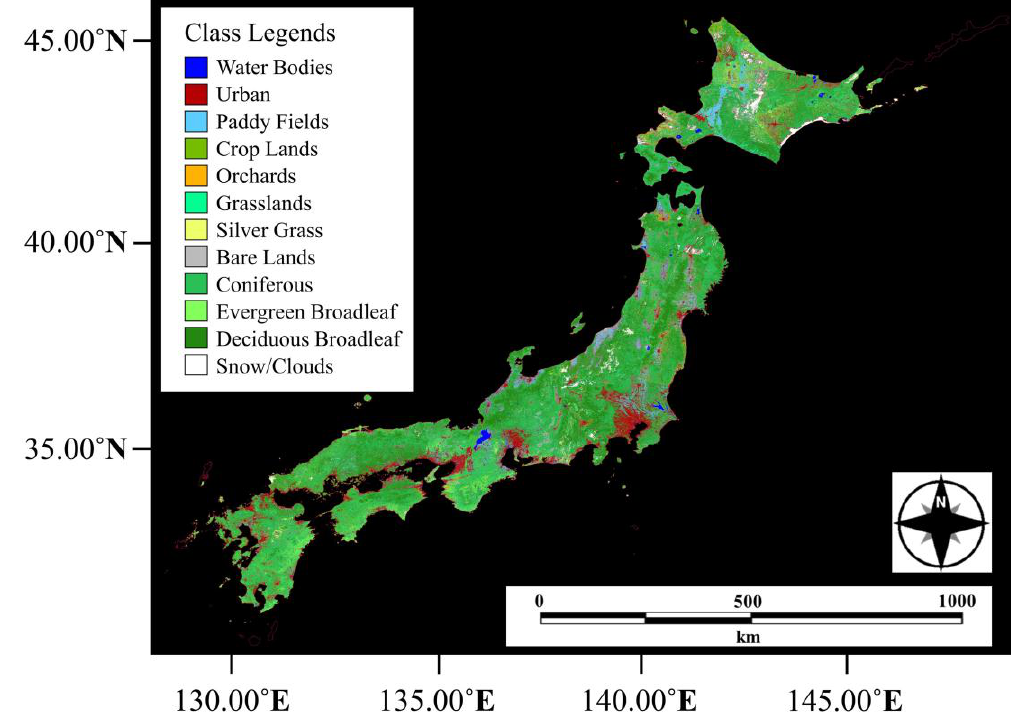
Figure 7. Land Cover map of Japan developed using 35 Landsat Operational Land Imager (OLI) scenes yielding 12 classes in